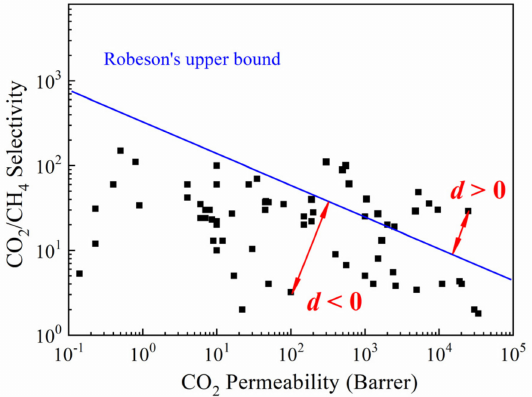
Figure 1. Permselectivity values (characteristic distance d ) of the CO 2 /CH 4 gas pair based on Robeson’s upper bound